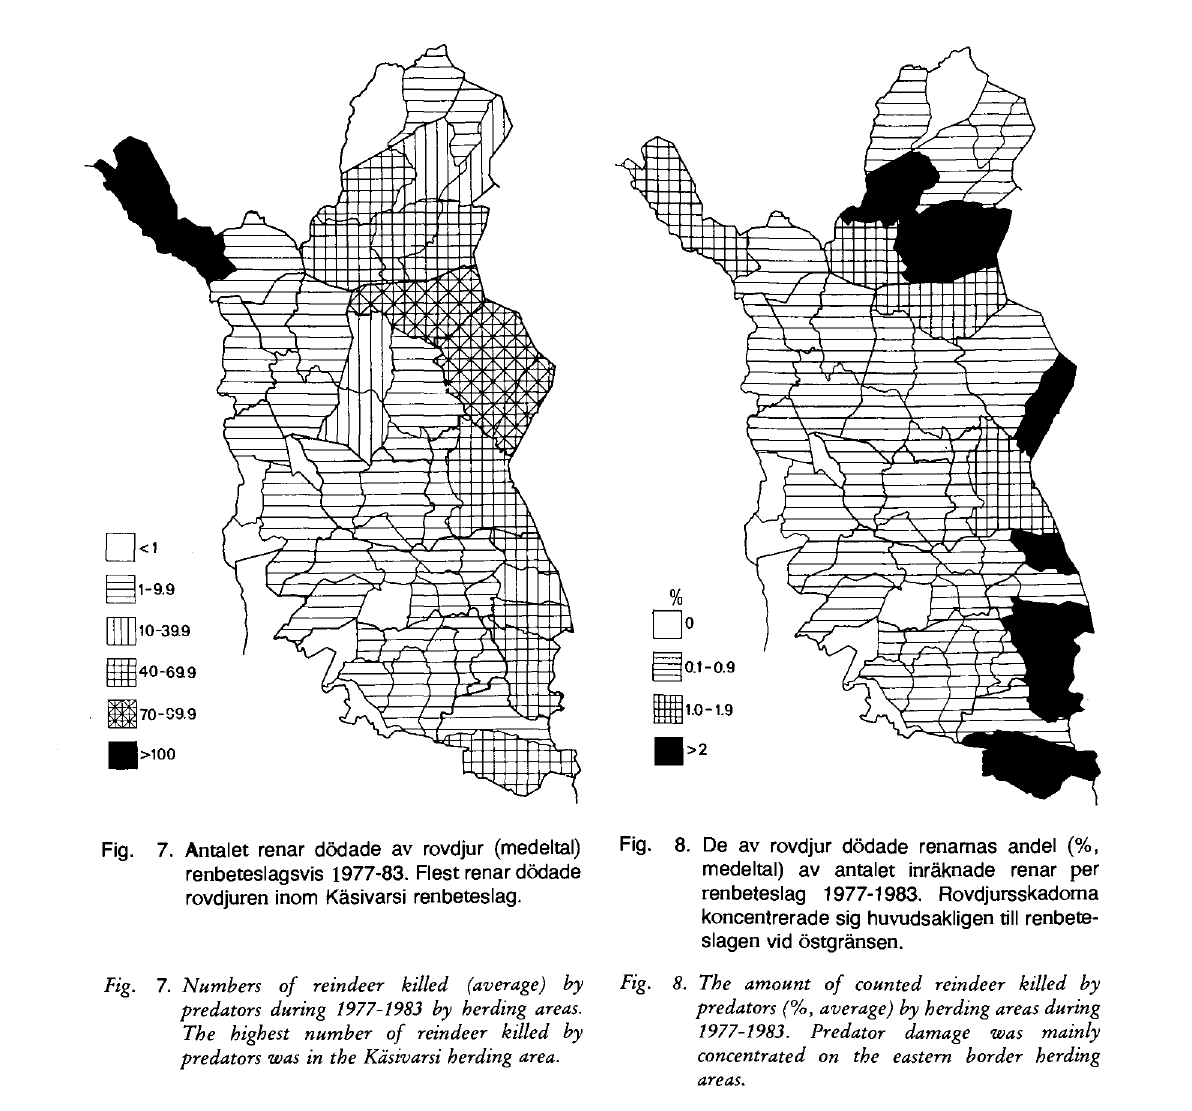
Fig. 7. Antalet renar dodade av rovdjur (medeltal) renbeteslagsvis 1977-83. Flest renar dodade rovdjuren inom Kåsivarsi renbeteslag. Fig. 7. Numbers of reindeer killed (average) by predators during 1977-1983 by herding areas. The highest number of reindeer killed by predators was in the Kdsivarsi herding area.